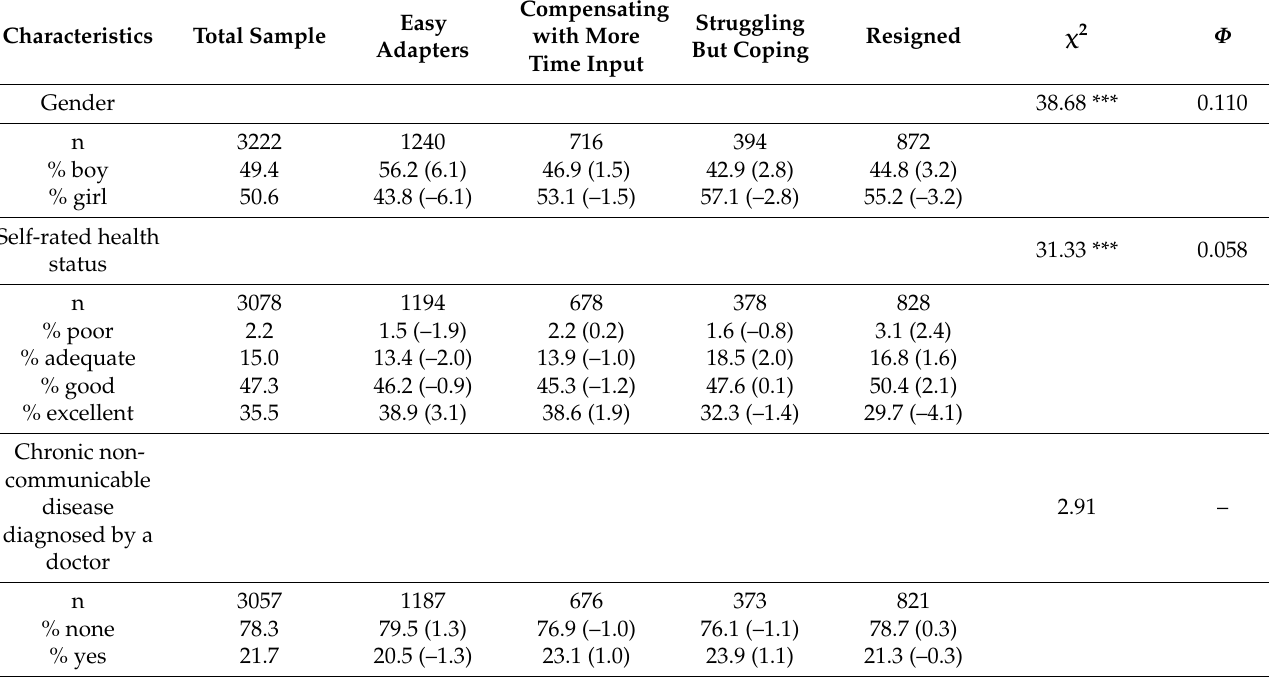
Table 1. Distributions by individual background characteristics in learner groups having different perceptions of online/digital distance learning.